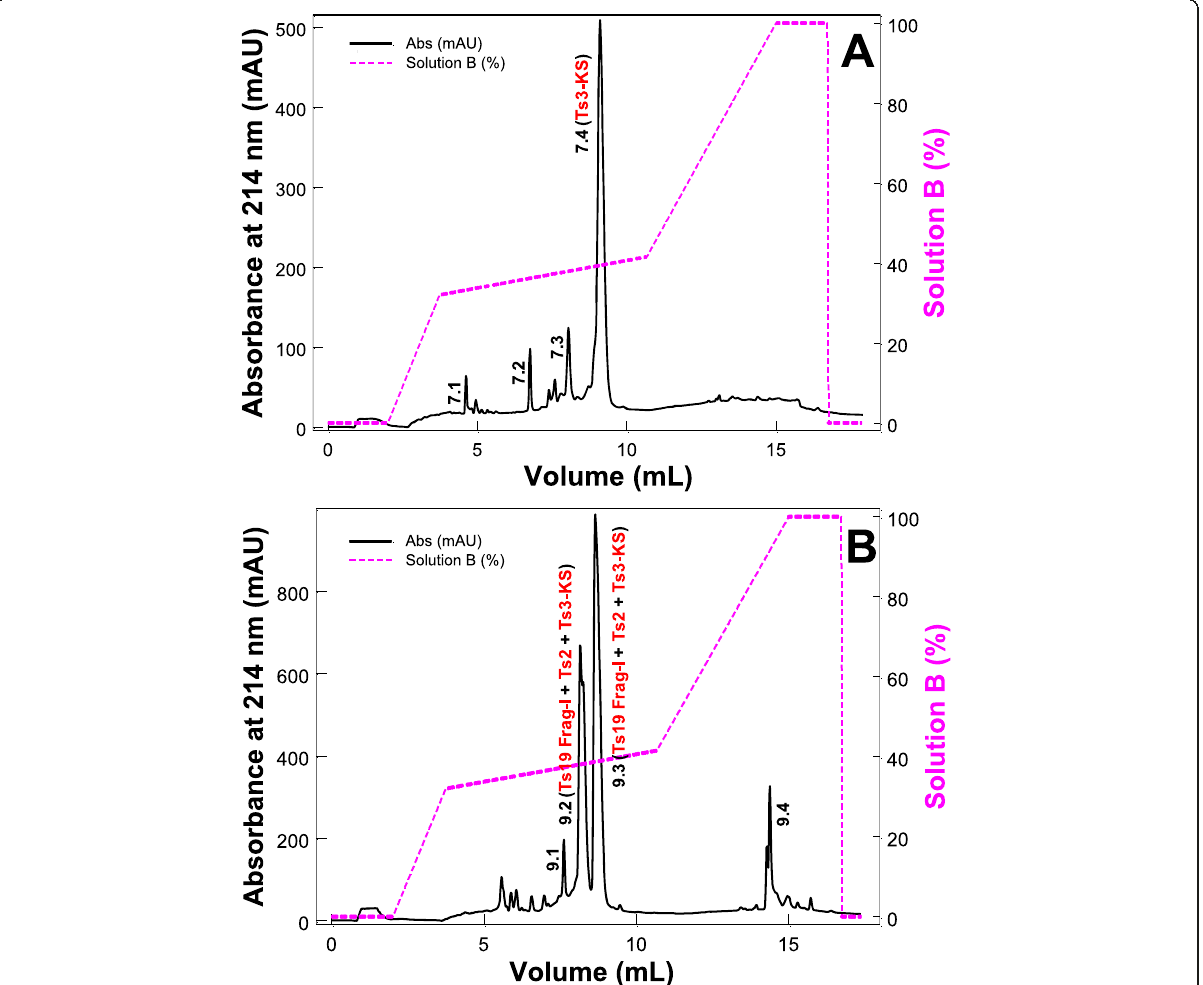
Fig. 2 Rechromatography of the subfractions eluted from the fractions VIIIA and VIIIB. ( a ) Subfraction 7. ( b ) Subfraction 9. The C18 column (2.1 mm × 250.0 mm, 3.6 μ m particles, Phenomenex) was equilibrated with 0.1 % TFA and the proteins were eluted using a concentration gradient from 0 to 100 % of solution B (80 % ACN in 0.1 % TFA), represented by the dashed line. Absorbance was monitored at 214 nm, at 25 °C, using a FPLC Äkta Purifier UPC-10 system. Fractions of 0.3 mL/tube were collected at a flow rate of 0.4